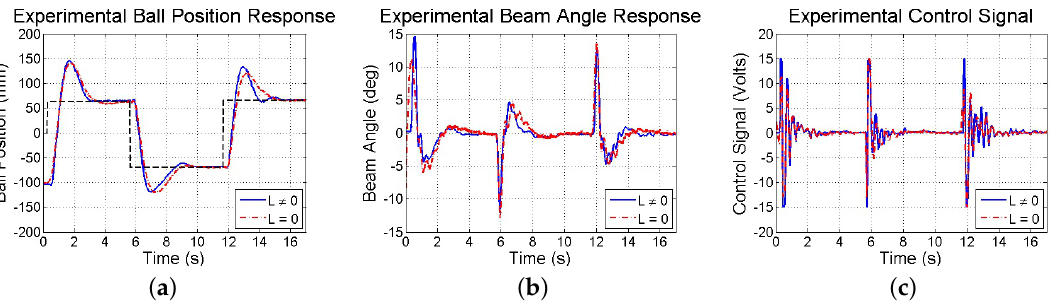
Figure 18. Experimental response of ( a ) ball position; ( b ) beam angle; and ( c ) control computed to step commands using two methods to estimate ˆ x p .